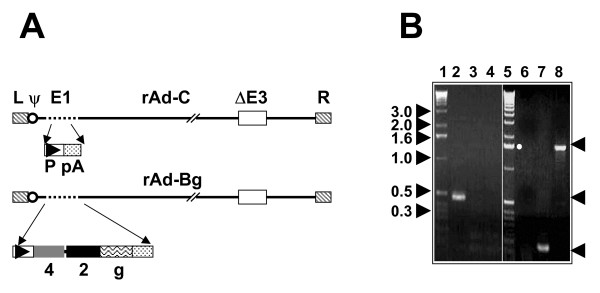
The rAds constructed for this study. (A) Schematic representation of the linear genomes of the rAd-C and rAd-Bg viruses. The dashed line, close to the left end represents the position of region E1. The open box located towards the right end represents a ~2.7 Kb deletion in the non-essential E3 region (ΔE3). The hatched boxes at either end represent the left (L) and right (R) inverted terminal repeats (ITRs), and the open circle close to the L-ITR represents the packaging signal (ψ). In the rAds, region E1 is replaced either by an empty expression cassette (rAd-C) or the EDIII-4/2 expression cassette (rAd-Bg). Components of the expression cassettes are indicated by the following abbreviations, P: CMV promoter (the arrow indicates its orientation); 4 and 2: DEN-4 and DEN-2 EDIII-encoding regions, respectively, of the bivalent EDIII-4/2 gene; g: enhanced green fluorescent protein gene (fused in-frame to the EDIII-4/2 gene) and pA: SV40 polyadenylation signal. (B) Characterization of the rAd genomes by PCR. The picture depicts agarose gel analysis of PCR products generated using wt Ad5 (lanes 2, 6), rAd-C (lanes 3, 7) or rAd-Bg (lanes 4, 8) viral DNA templates. Primers used were either E1-specific (lanes 2–4) or specific to insert-flanking sequences (lanes 6–8). DNA size markers were run in lanes 1 and 5. Sizes of the lane 1 markers (in Kb) are indicated to the left of the panel. The position of the 1.6 Kb band in lane 5 is indicated by a white dot for orientation. The arrows to the right indicate the positions of the amplicons corresponding to the bivalent insert (top), E1 region (middle) and the insert-less vector sequences (bottom).